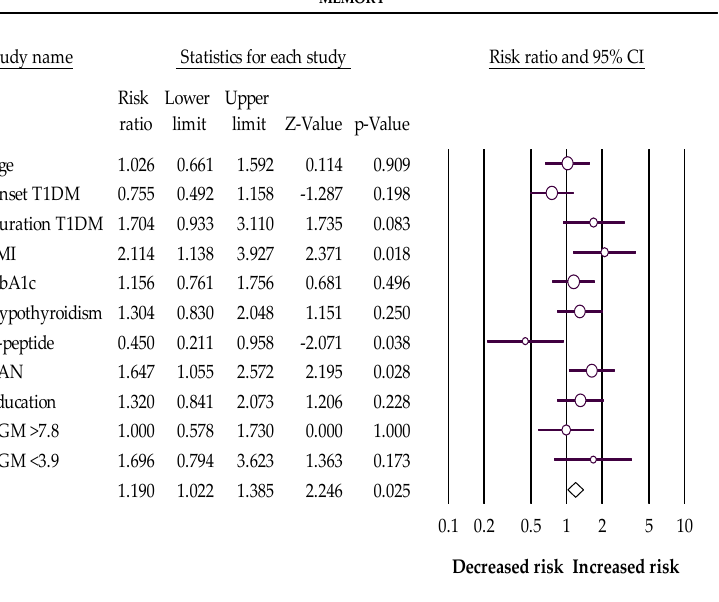
Figure 2. The Forest plot represents the relative risks for memory (Q-value 19.464, df 10, p -value 0.035, I 2 48.623). The following data are presented: age, age of onset disease, duration of disease, BMI, HbA1c %, subclinical hypothyroidism, C-peptide preservation, cardiovascular autonomic neuropathy (CAN), level of education, percentage of glucose concentration >7.8 mmol/L, and percentage of glucose concentration <3.9 mmol/L measured with a continuous glucose monitor (CGM). Empty circles represent the relative risk of effect for each category; horizontal lines around circles indicate confidence intervals, and the central vertical line represents the magnitude of the null